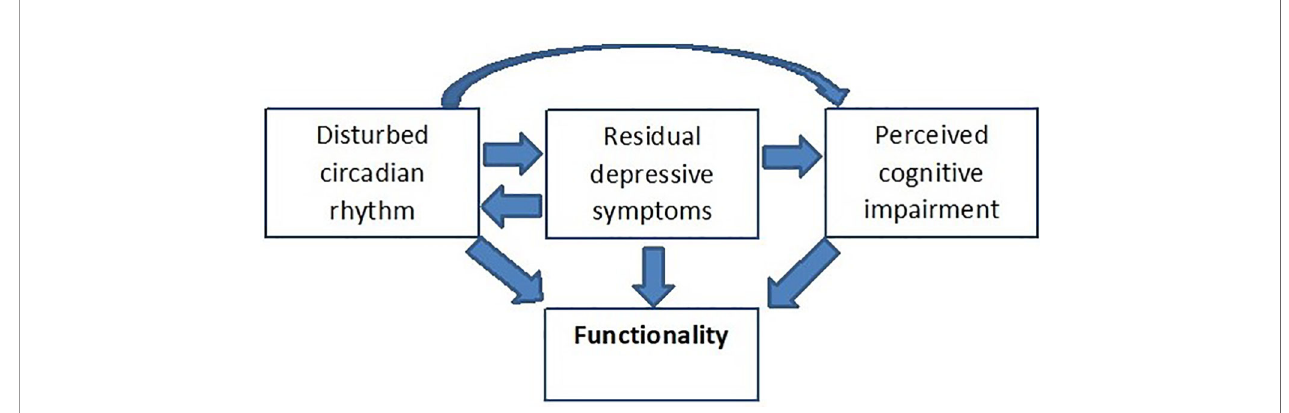
FIGURE 1 | The trias of SSBD, their interaction and impact on functionality. A hypothetical model adapted from (5). Applying a structural equation model (SEM), Samalin et al. (5) demonstrated a signi fi cant direct effect of both residual depressive symptoms and perceived cognitive impairment on functionality. In addition, residual depressive symptoms also have a direct effect on perceived cognitive impairment but no signi fi cant indirect effect on functioning via perceived cognitive impairment. The direct pathway between sleep disturbances and functioning was not signi fi cant, however, the SEM con fi rmed the presence of a moderate indirect effect of sleep disturbances on functioning via residual depressive symptoms and perceived cognitive